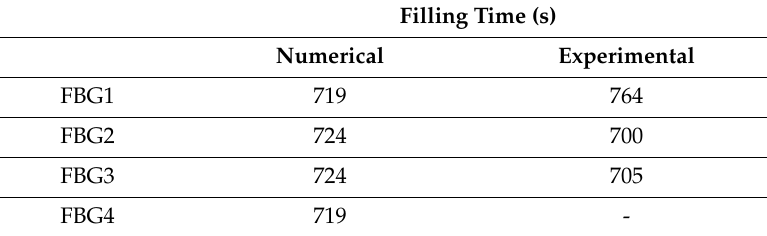
Figure 13. Top view of the stiffened panel manufactured by resin infusion. Table 5. Comparison between experimental and numerical results.